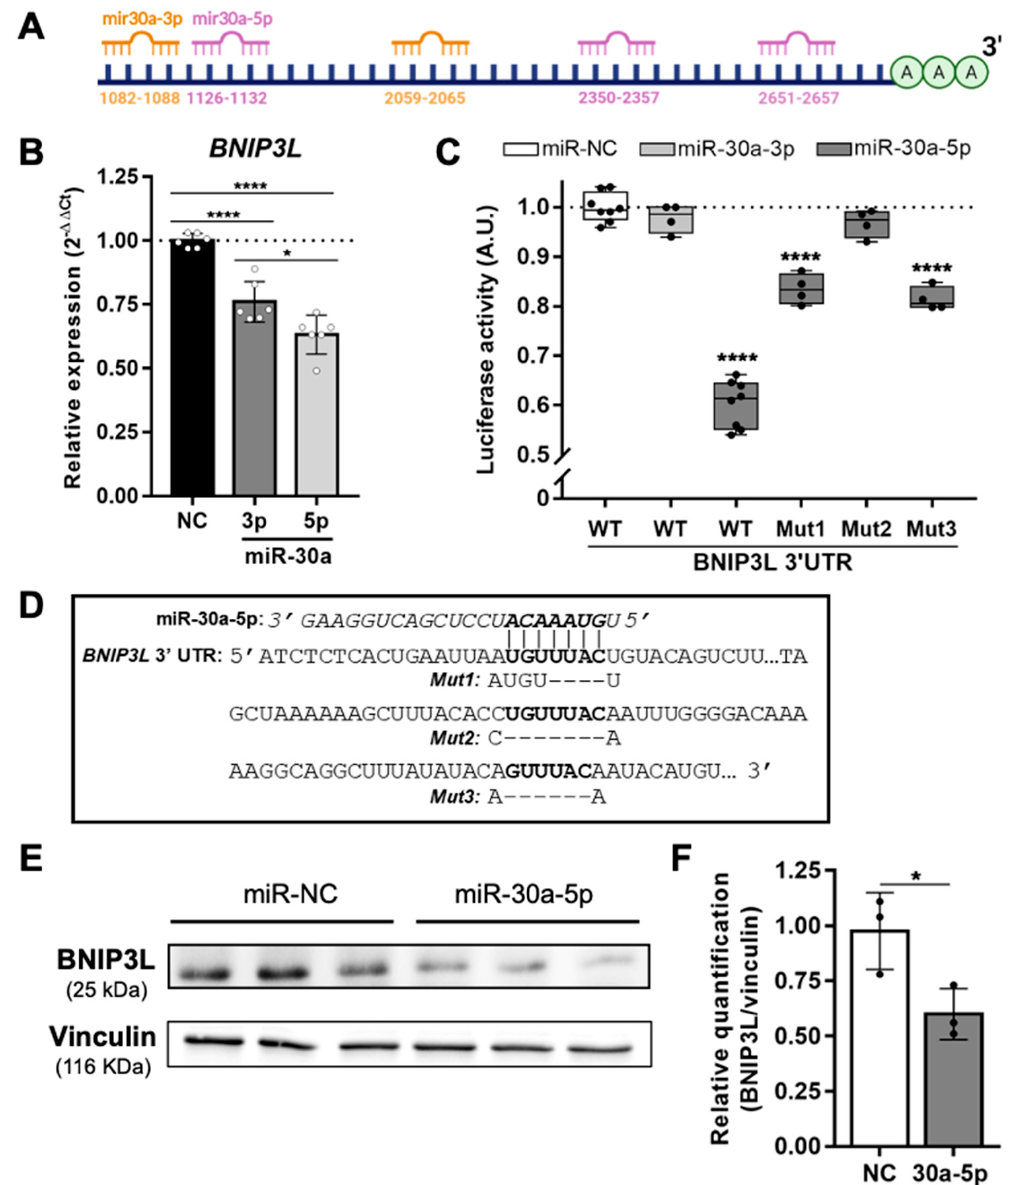
Figure 1. miR-30a interactions with BNIP3L . ( A ) Schematic of the BNIP3L 3’UTR region showing the putative miR-30a binding sites. ( B ) Relative mRNA expression of BNIP3L in keratinocytes 24 h after transfection of miR-30a-3p or miR-30a-5p mimics or a scrambled sequence (NC: Negative Control). qPCR analysis was normalized to TBP and RPL13A housekeeping genes using the 2 −ΔΔ Ct quantification method (mean ± SD, n = 6; * p < 0.05 and **** p < 0.0001). Exact p -values were determined using the one-way ANOVA and Tukey post-hoc tests. ( C ) Normalized luciferase activity (red firefly/green renilla) after co-transfections of HEK293T cells with the Wild-Type (WT) or Mutant (Mut) reporter plasmids and miRNA mimics (median ± SD, n = 4 or n = 8; **** p < 0.0001). Exact p -values were determined using the one-way ANOVA and Tukey post-hoc tests. ( D ) Schematic of a portion of BNIP3L 3’UTR region with the three putative complementary pairing sites with miR-30a-5p. The mutated sites, obtained by inverse PCR and characterized by Sanger sequencing, are also indicated below the original sequence. ( E ) Western blot analysis of keratinocytes of BNIP3L (25 kDa) expression 36 h after transfection of miR-30a-5p mimics or a scrambled sequence (NC: Negative Control). Western blot analysis of Vinculin (116 kDa) was used as a loading normalizer. ( F ) Quantification of BNIP3L expression normalized by the expression of Vinculin (mean ± SD, n = 3; * p < 0.05). Exact p -value was determined using the Student’s t -test.